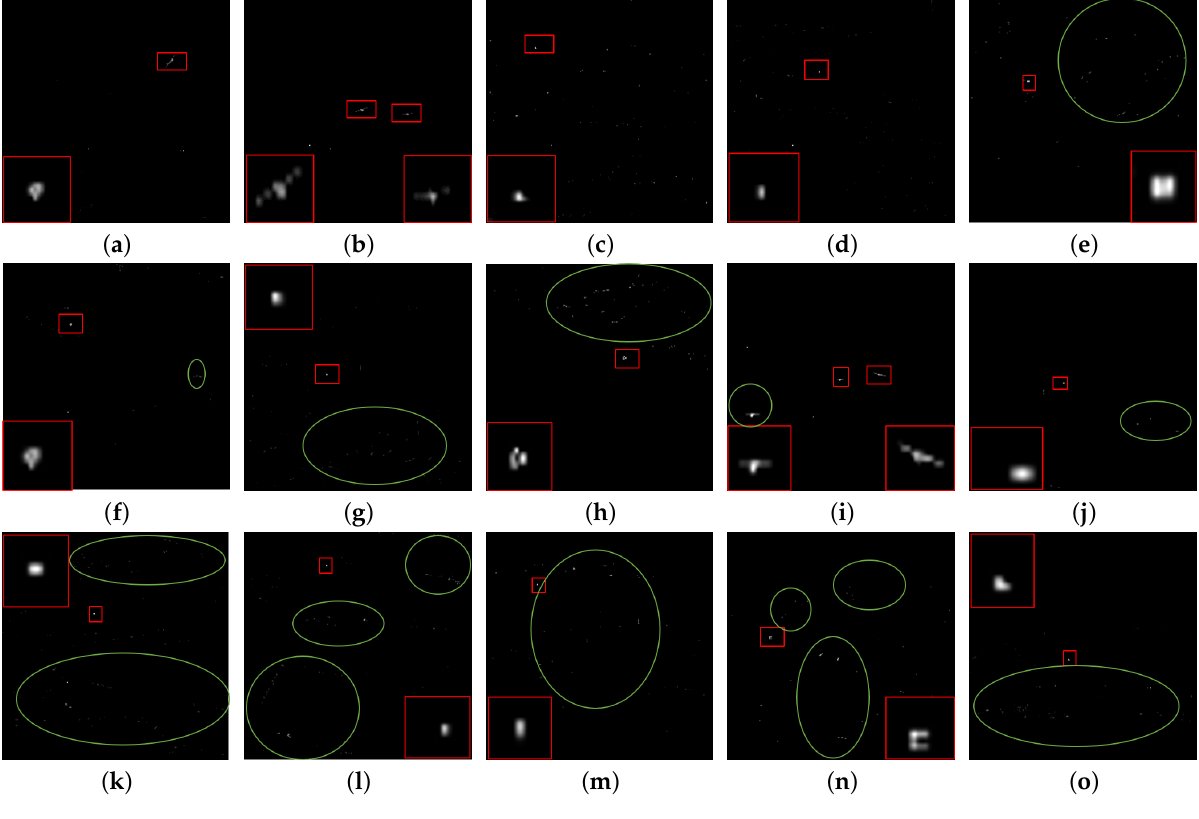
Figure 16. Targets detected in 15 different sequences by using LogTFNN. ( a – o ) represent the corre- sponding scenes in Figure